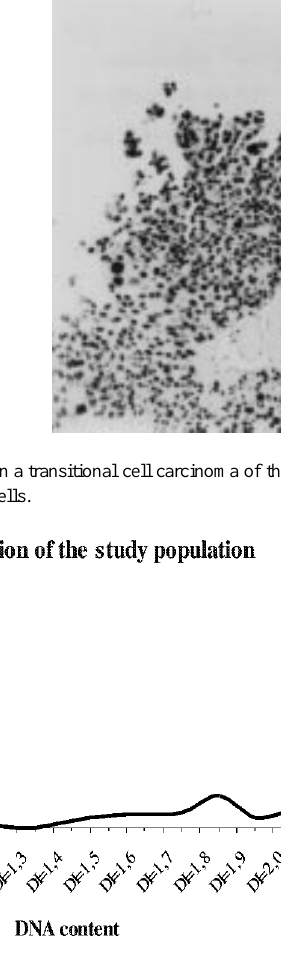
Fig. 5. Distribution of DIs of the study